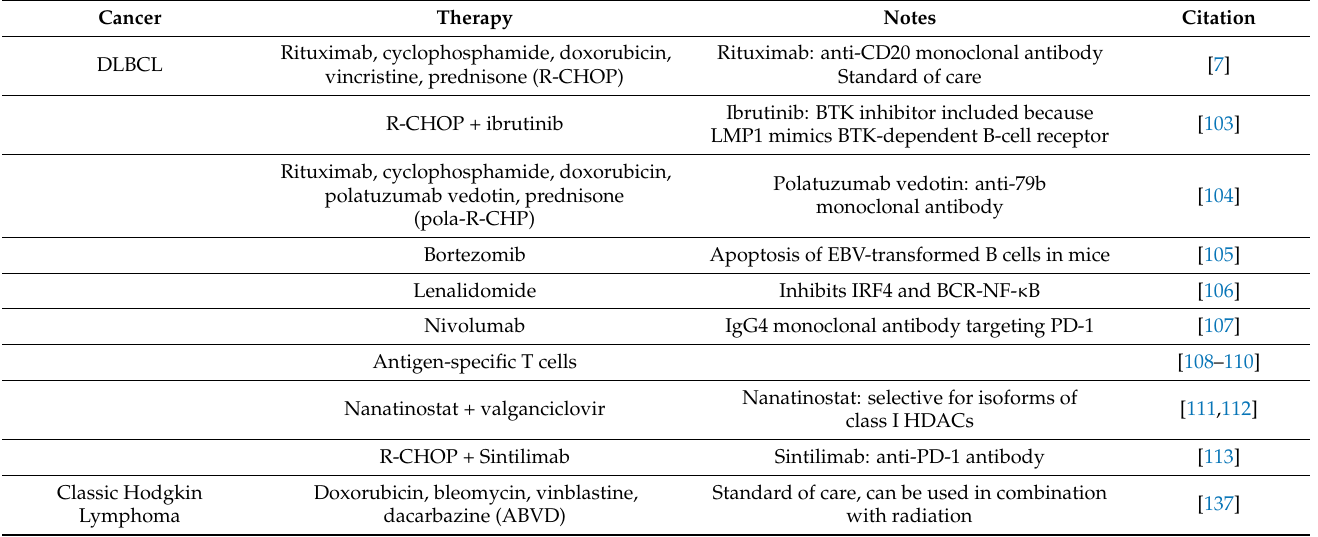
Table 1. Treatment for EBV-related